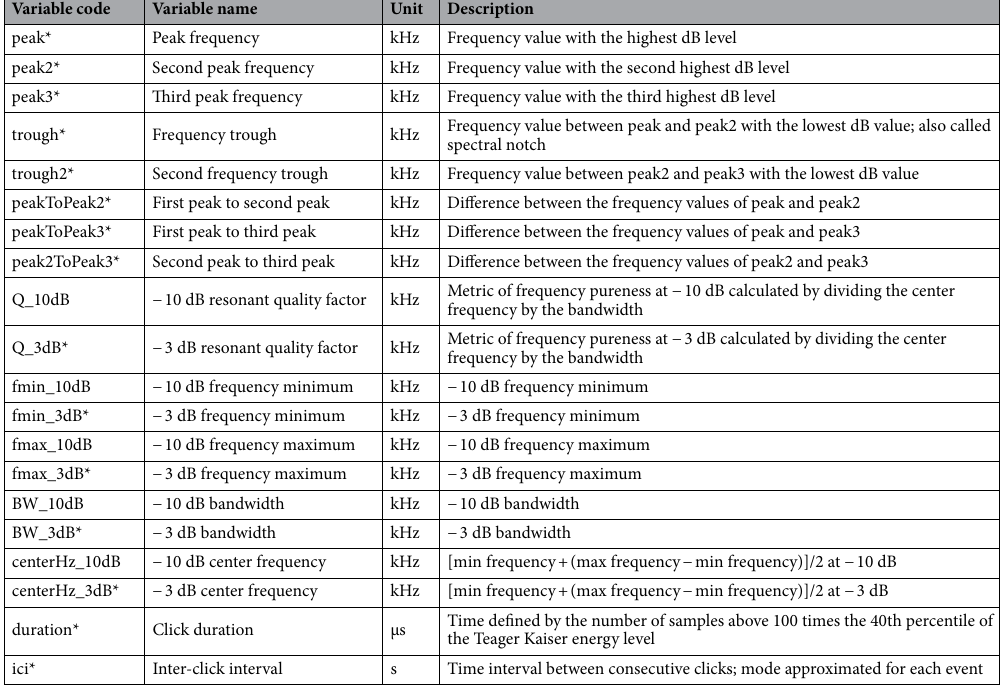
Table 1. Descriptions of echolocation acoustic parameters used as variables in species differentiation analyses and classification models. All parameters outlined here were used for the standard Random Forests classification model and BANTER’s first stage call classifier. Variable codes marked with an asterisk (*) indicate which acoustic parameters were used for multivariate differentiation analyses. A full list and the process used by the PAMpal package 61 for calculating click parameters can be found in the R package documentation 65